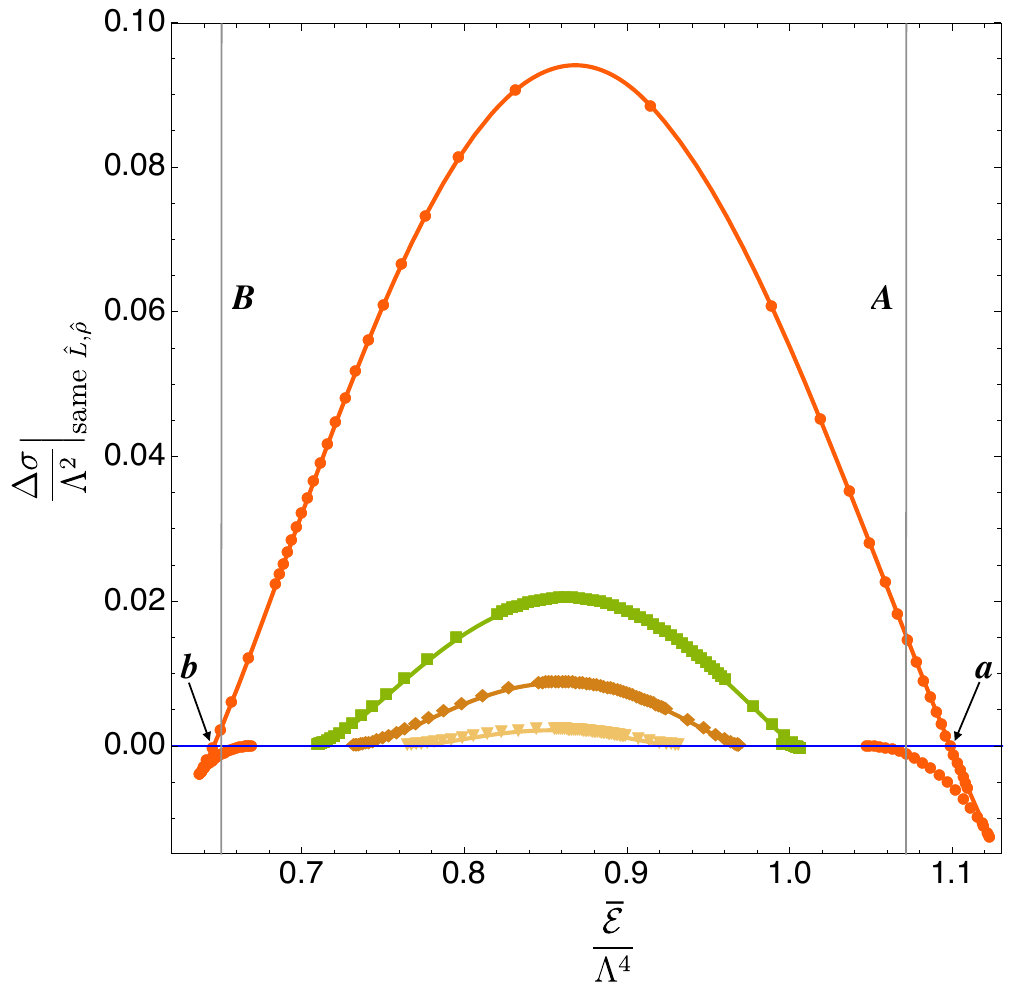
Figure 18 . Killing entropy density difference ∆ˆ σ | sameˆ with the same (ˆ L, ˆ ρ ) or, equivalently, with the same (ˆ L, ˆ age energy density E